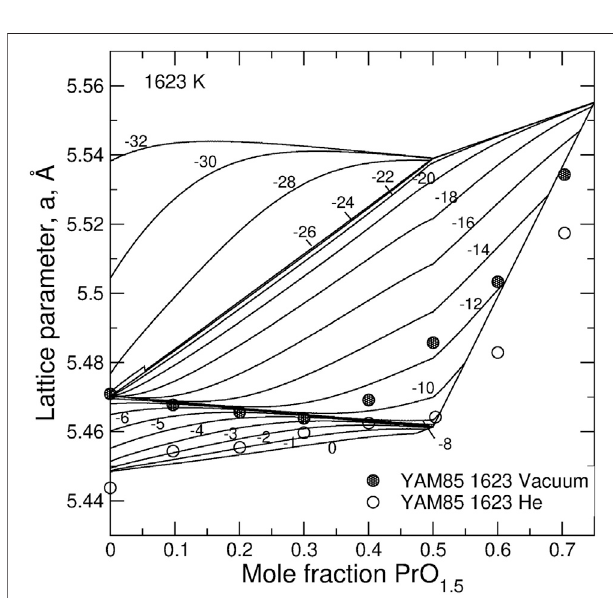
FIGURE 8 | Relationship between the lattice parameter and the degree ofdoping, z ,andlog (cid:1) P O / P 0 (cid:3) inPrO 1.5 -UO 2 systempredictedfromthemodel. 2 TheexperimentaldataseriesfromYamashitaetal.(Yamashitaetal.,1985)are interpreted to be synthesized at log (cid:1) P O / P 0 (cid:3) of – 2 and – 12. 2